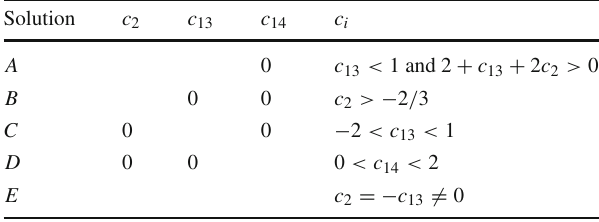
Table 1 Summary of the Aether conditions